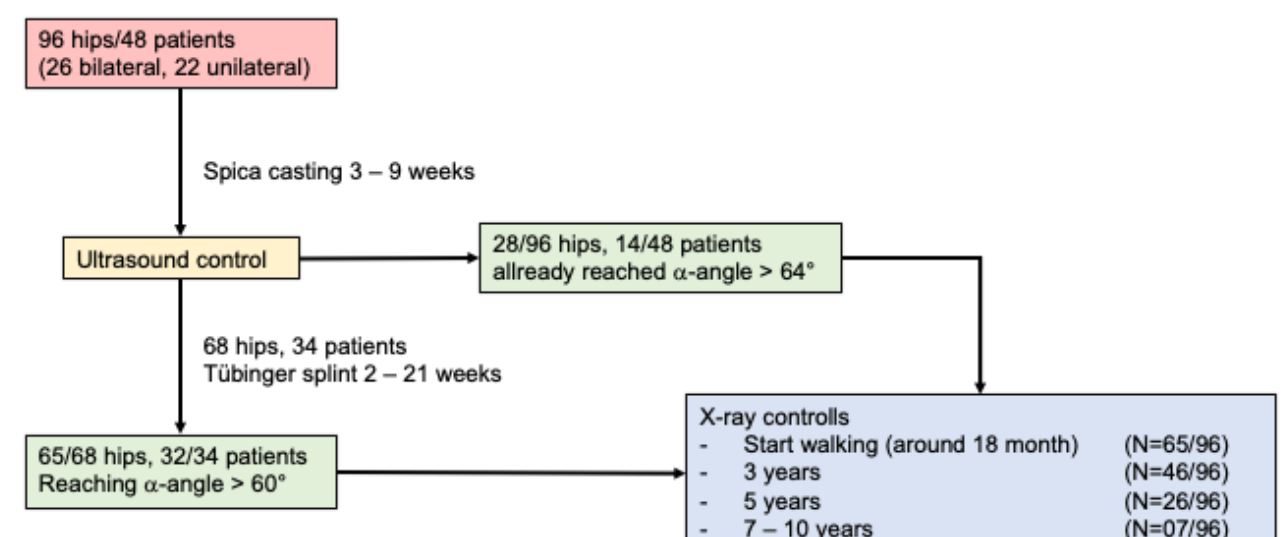
Figure 1. Shows the therapy algorithm of our treatment.